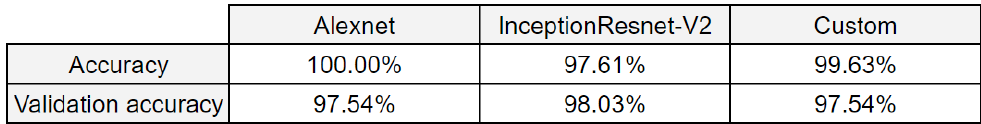
Figure 14. Comparing among Alexnet, InceptionResNetV2 and the Custom CNNs for the use case of the